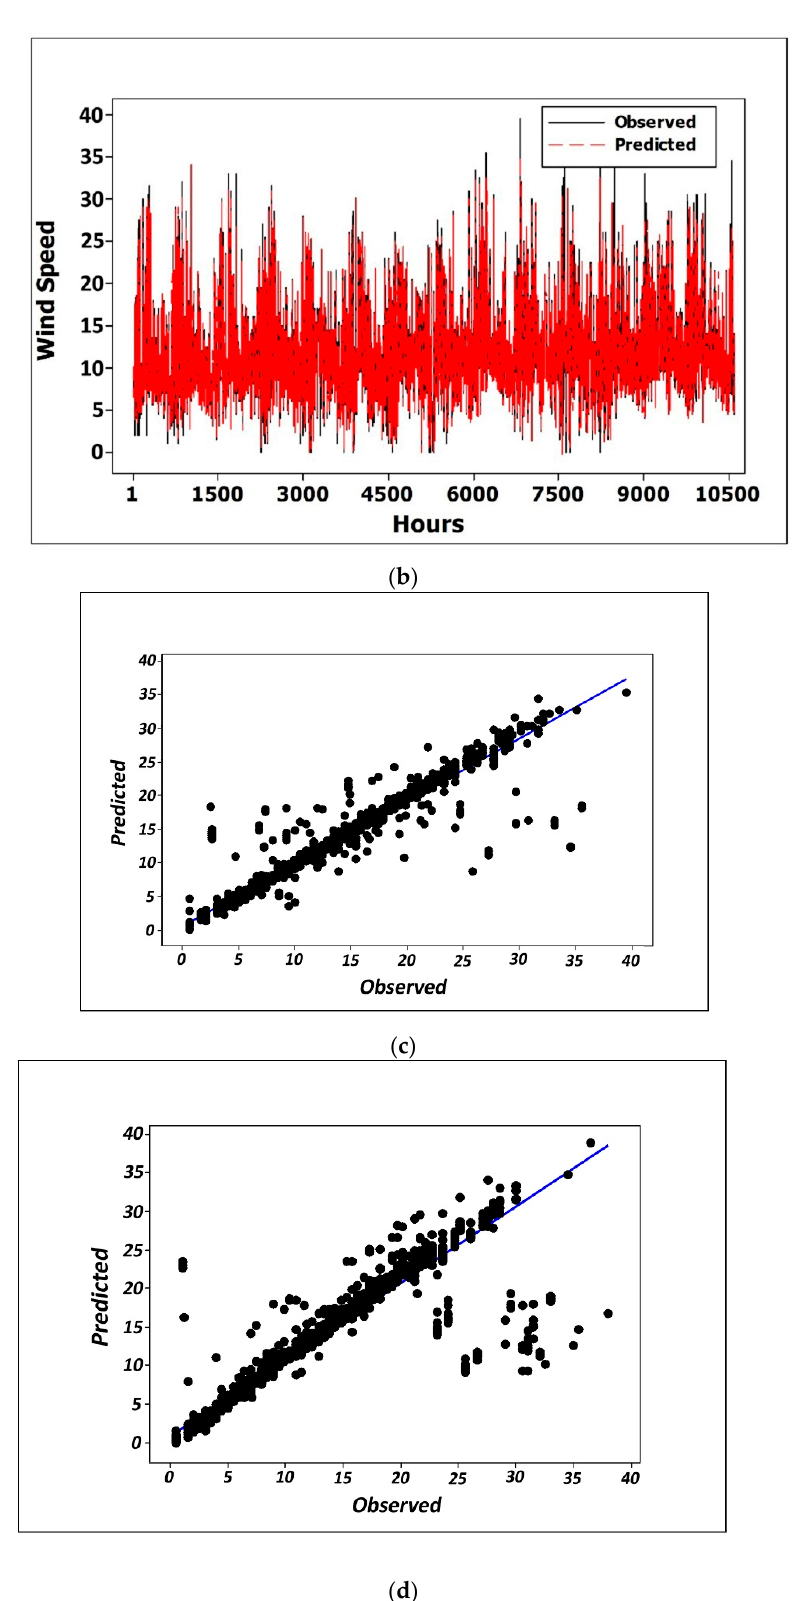
Figure 10. Wind speed forecast using the LSTM model (81-14-1) during ( a ) training, and ( b ) testing periods, and scatter plots showing the positive linear correlation between the observed time series and the predicted values in ( c ) training, and ( d ) testing